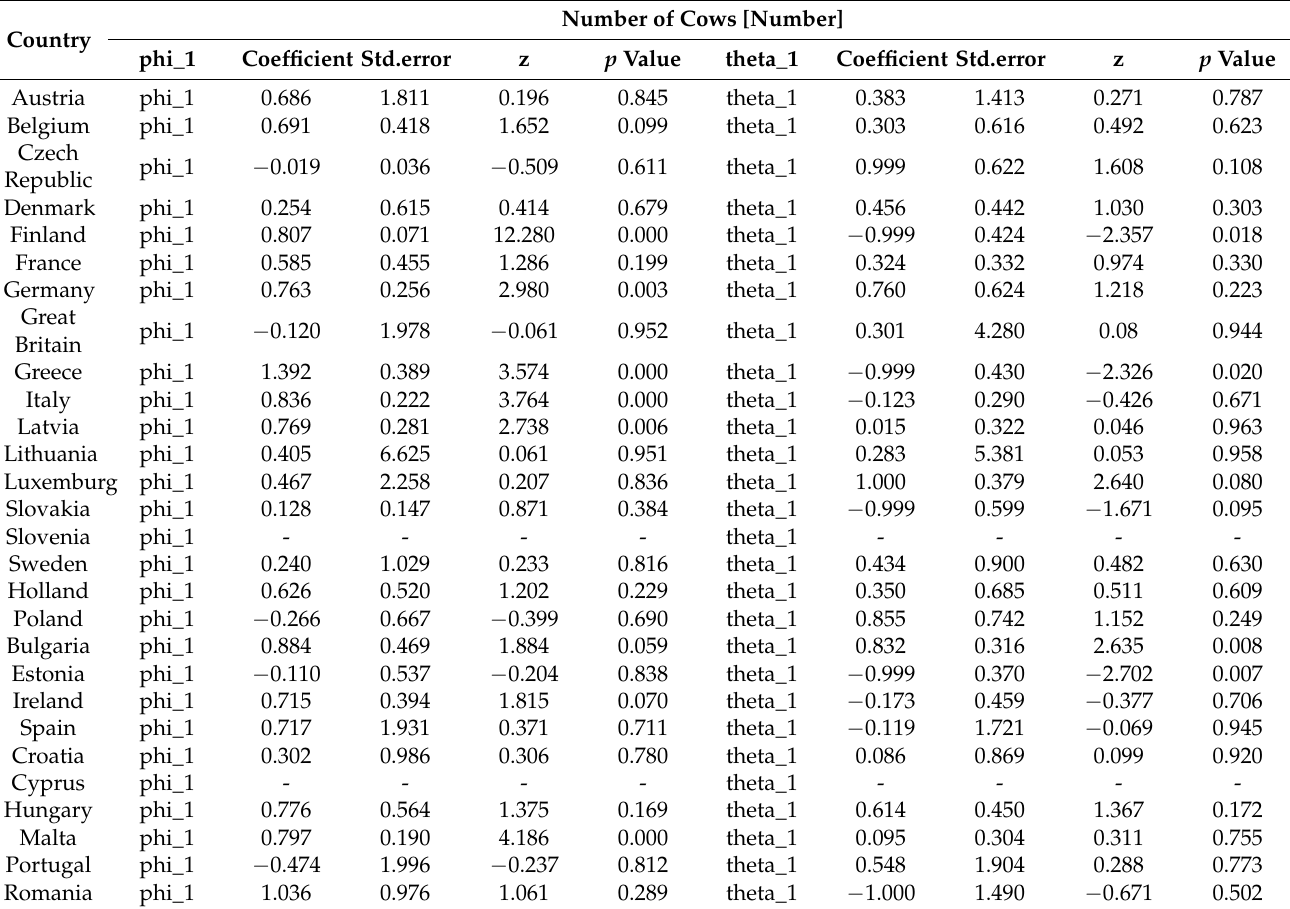
Table 2. Autoregressive integrated moving average model (ARIMA) model of organic cows in the EU. Number of Cows Country